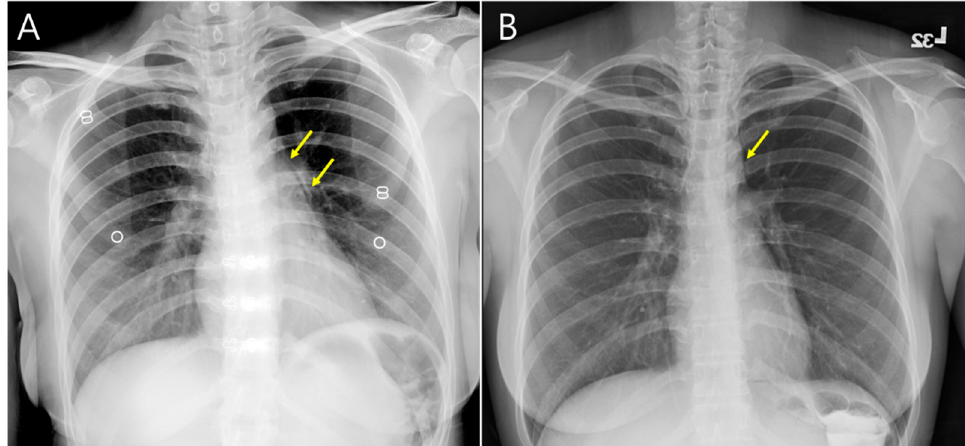
Figure 5. Sequential chest X-ray ( A ) on admission day and ( B ) discharge day showed improvement of pneumomediastinum (yellow arrow). There was no pleural effusion and pericardial effusion.